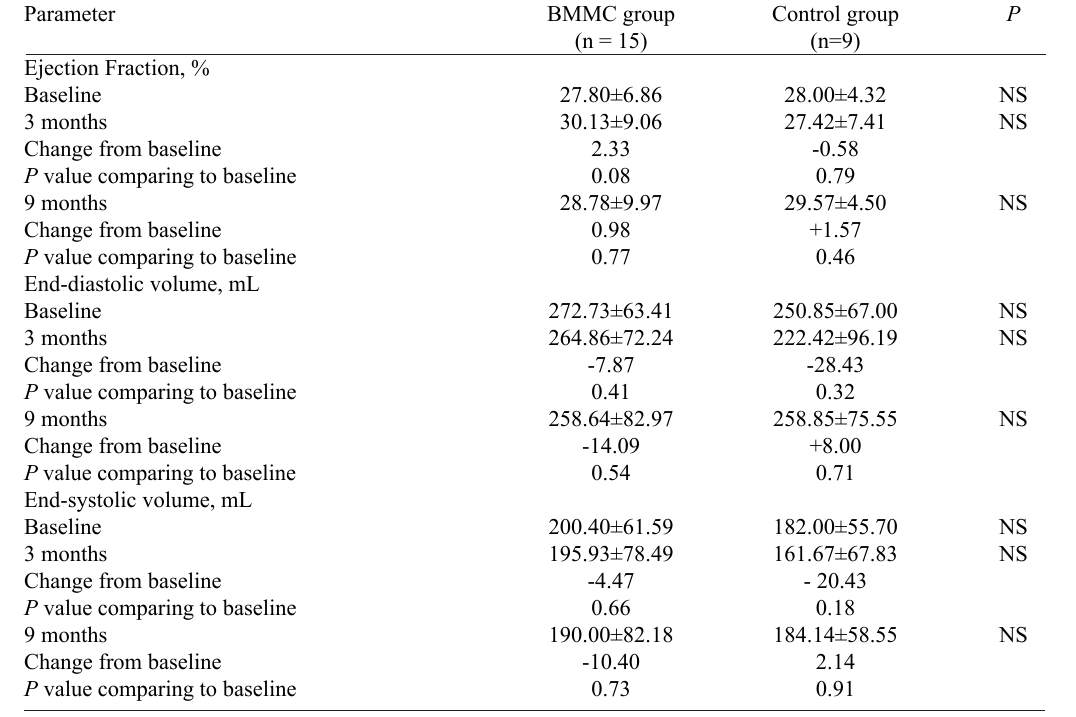
Table 3. Left ventricular volumes and function as assessed by Magnetic Resonance Imaging